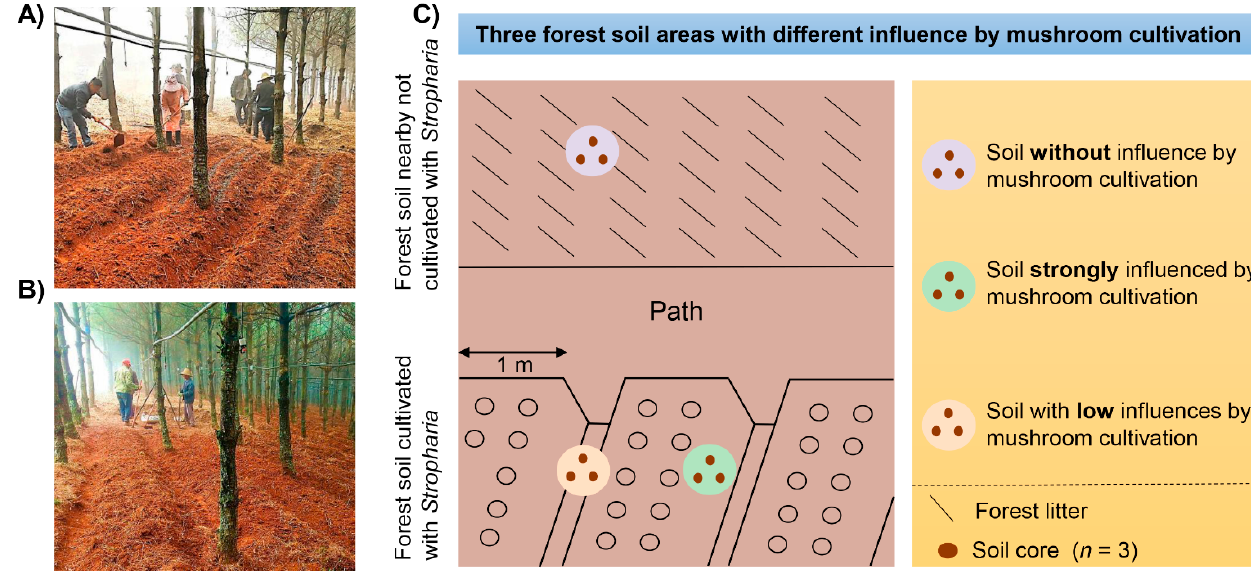
Figure 1. Overview of the forest sites ( A , B ); and sampling scheme ( C ) of Stropharia rugosoannulata cultivation areas: (i) Grey circle = Control forest soil with no influence from mushroom cultivation (C); (ii) Pale pink circle = Soil from the grooves with low influence by mushroom cultivation (L); and (iii) Green circle = Soil below the fungal beds strongly influenced by mushroom cultivation (S).